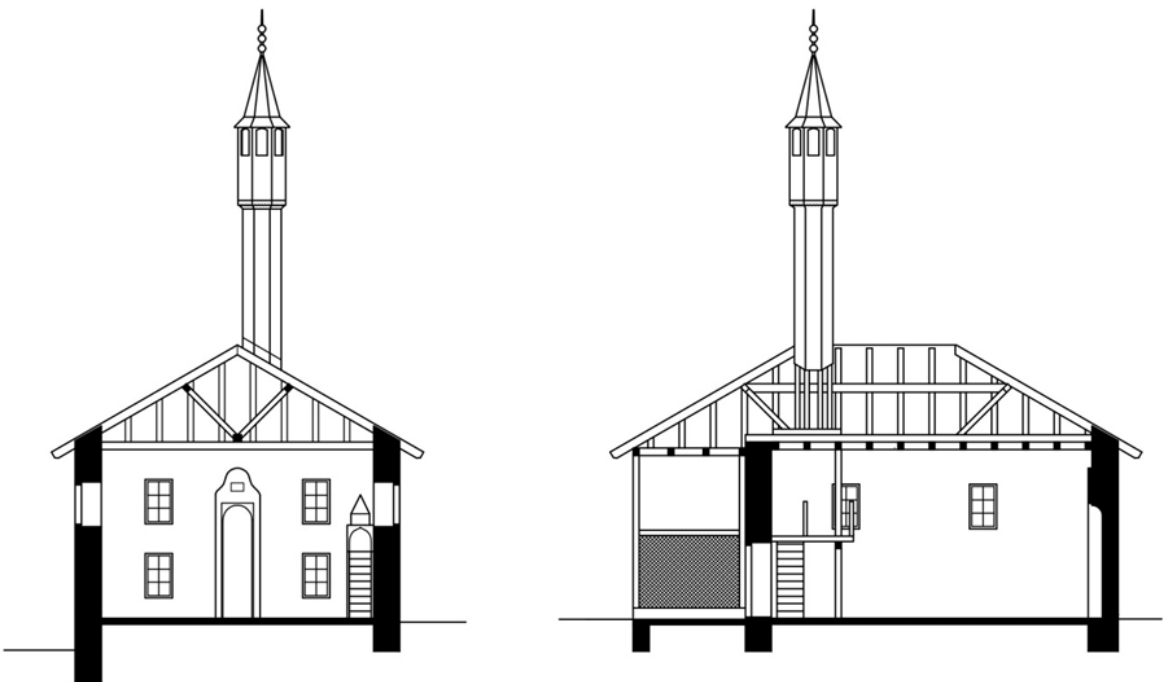
Figure 3. Cross sections of Osman Ćehaja Mosque: Transverse (left), Longitudinal (right), (drawings by the